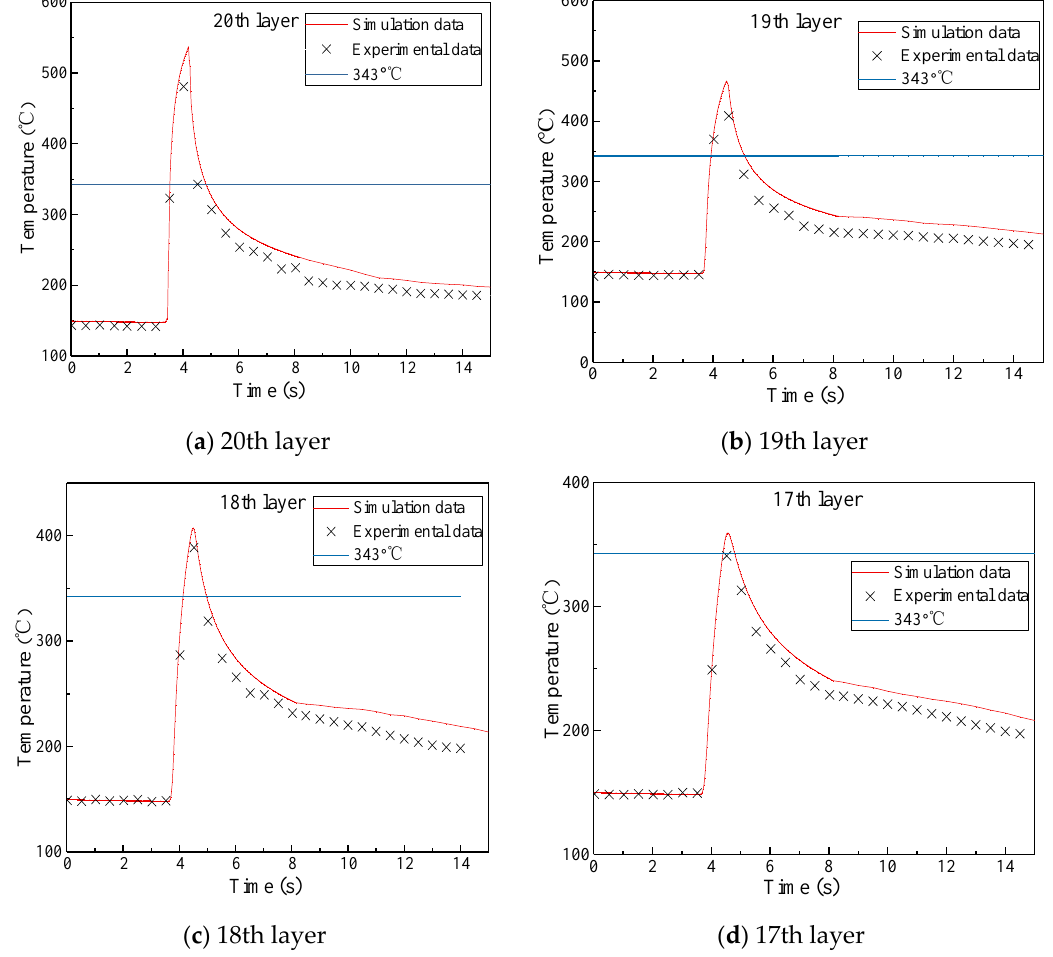
= 20 mm / s and T = 700 ◦